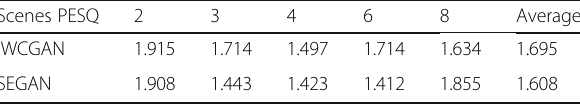
Table 1 The standard of speech quality evaluation PESQ Scenes